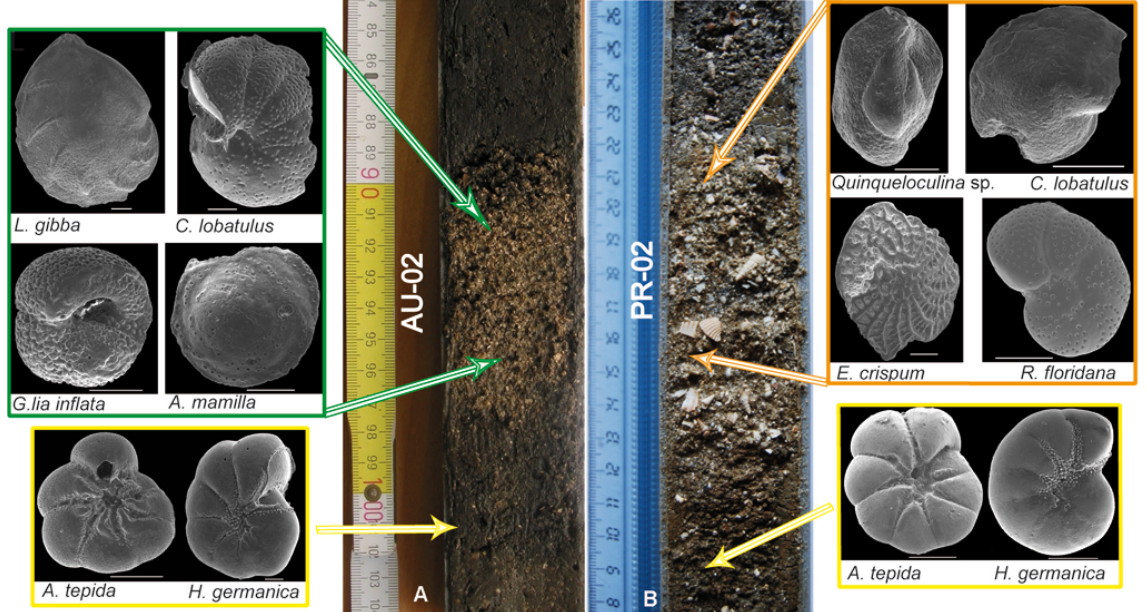
Fig. 3. Examples of paleotsunami deposits found at the two Augusta Bay inland sites. (A) Augusta site: picture of the bioclastic layer (event AU-02 from the OSA-S6 core found at − 1.95m of depth) showing a sharp erosional basal contact and no evidence for internal structures or grading. The FESEM images on the left (the scale bar below each pictures represent 100µm) show some selected Foraminifera found in coincidence of the bioclastic layer (green box) and just above and below it (yellow box). (B) Picture of a bioclastic layer with sharp (probably erosional) basal contact (event PR-02 from the OPR-S11 core found at − 0.60m of depth), displaying a large amount of shell fragments and gastropods (Pirenella conica, with abrasions probably due to high energetic transport). FESEM images on the right show selected Foraminifera collected within the high-energy layer (orange box) and above and below it (yellow box). The Foraminifera in the yellow boxes are typical of lagoonal environments, whereas those in the green and orange boxes are typical of open marine